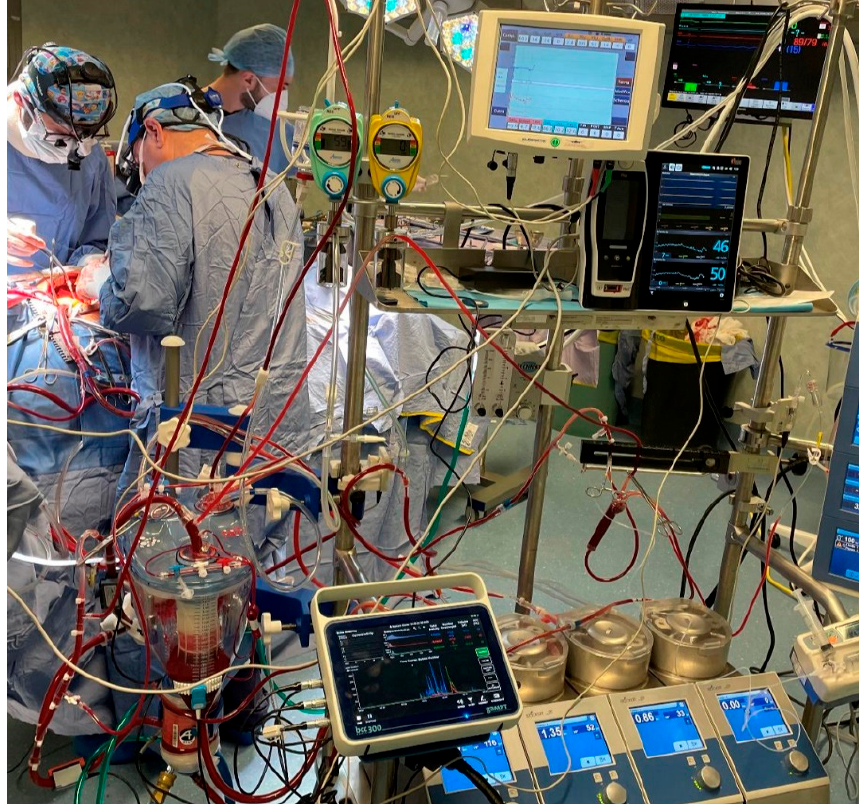
Figure 5. Horizon AF PLUS during cardiopulmonary bypass use with GAMPT BC300.